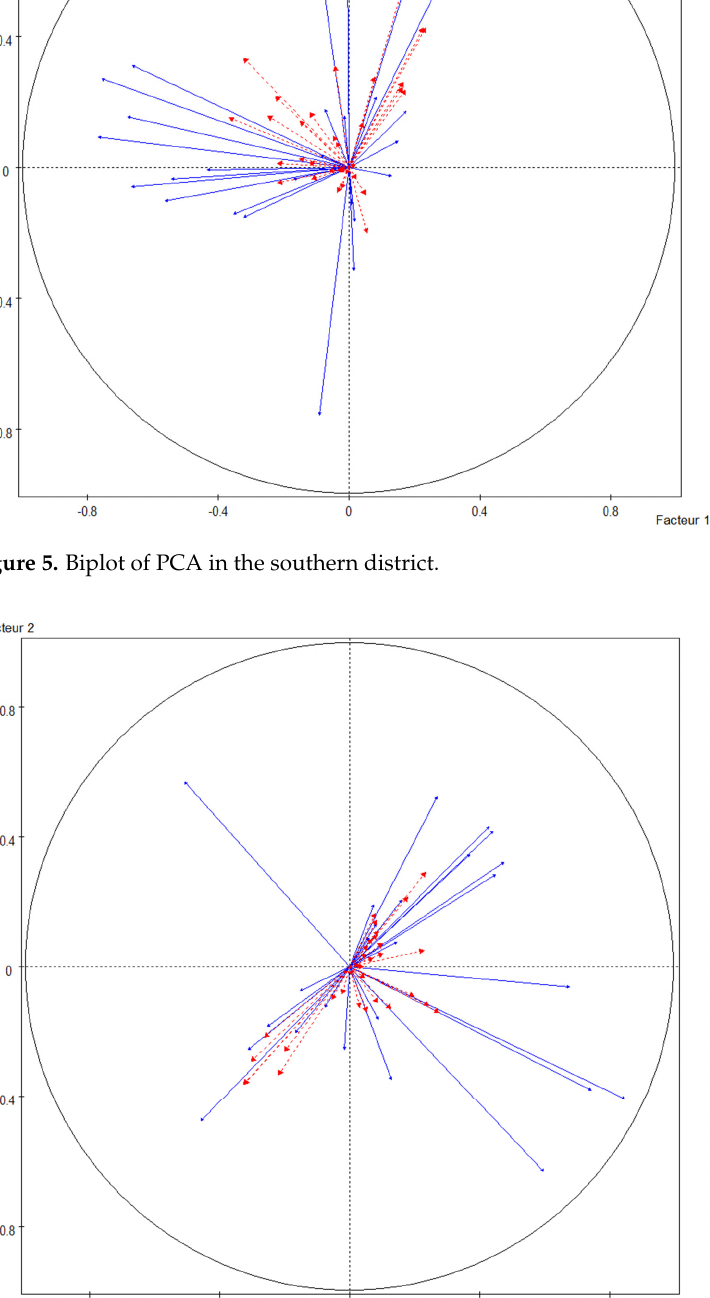
Table 3. Number of farms in each cluster by geographical division.